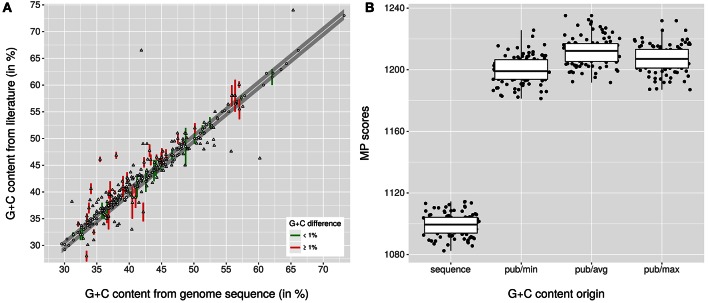
Relationship between G+C content values from species descriptions and those calculated from the genome sequences. (A) scatter plot showing the relationship between G+C content values calculated from the genome sequences and those found in the respective last revision in the literature, mostly calculated traditionally. The gray band indicates the boundary of 1% deviation, green color (when ranges were provided) and circles indicate values within that range, red color and triangles indicate values outside that range. (B) box plots showing the MP scores calculated with TNT from the rescaled G+C content values of distinct origin (pub, published; min, avg and max refer to whether the lower, average or upper value was used when a range was given) in conjunction with the 100 pseudo-bootstrapped GBDP trees. The values calculated from the genome sequences yield a significantly lower MP score (and thus a significantly better fit to the tree) than the ones from the respective last emendation in the literature.